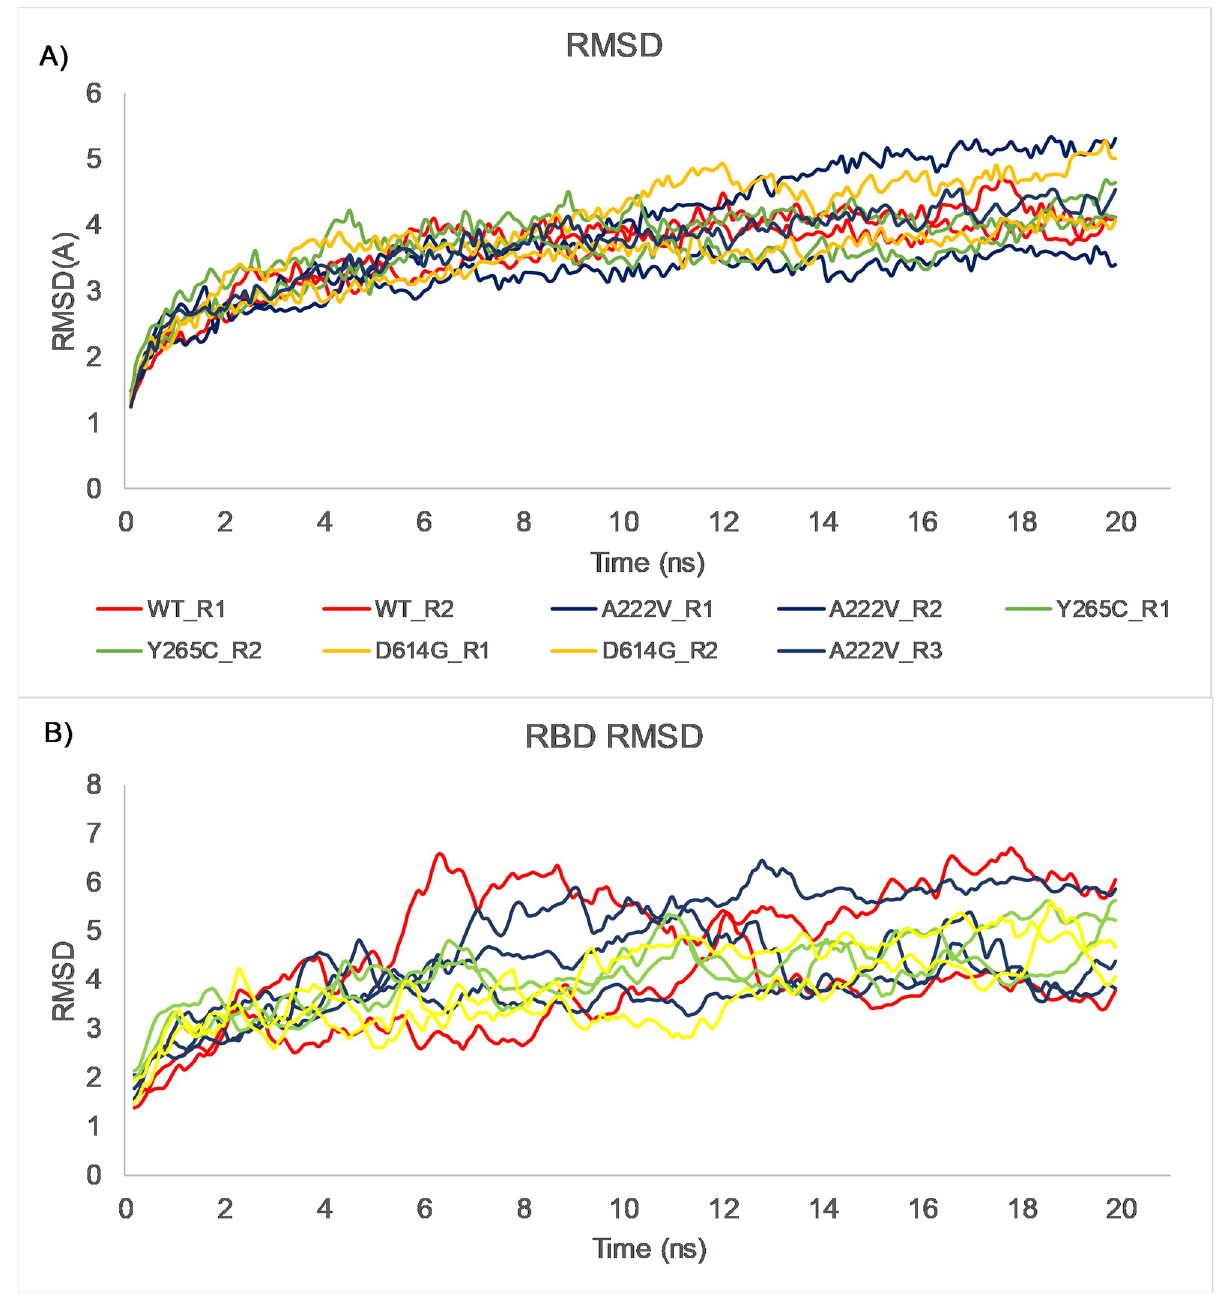
Fig 6. Molecular dynamics simulations. (A) RMSD of alpha carbon atoms of the reference SARS-CoV-2 spike protein (WT) and its single mutations (A222V, Y265C, and D614G) versus time at 310.15˚K. (B) RMSD of alpha carbon atoms of the reference SARS-CoV-2 spike protein (WT) and its single mutations (A222V, Y265C, D614G) versus time at 310.15 K around the ACE-2 Receptor Binding Domain residues. Running averages of each RMSD value are plotted.